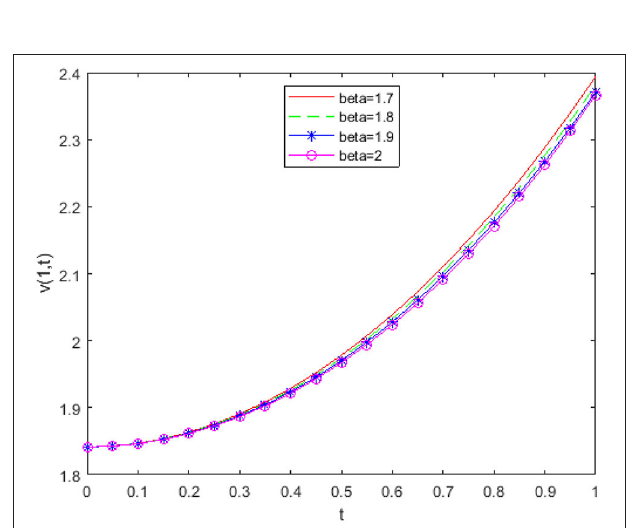
FIGURE 4 | Approximate solution at different values of t and β at x =